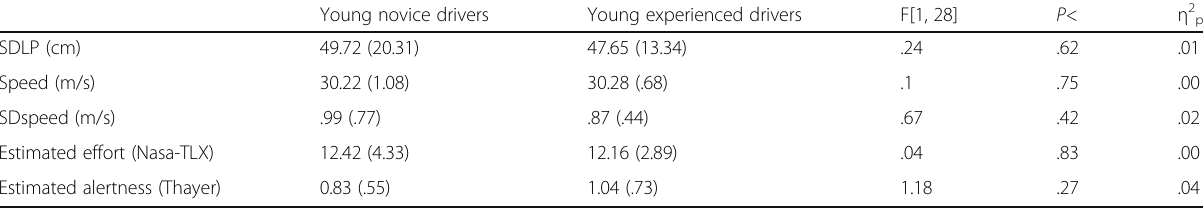
Table 2 Mean driving performance, estimated effort and estimated alertness after driving as a function of experience (SD between